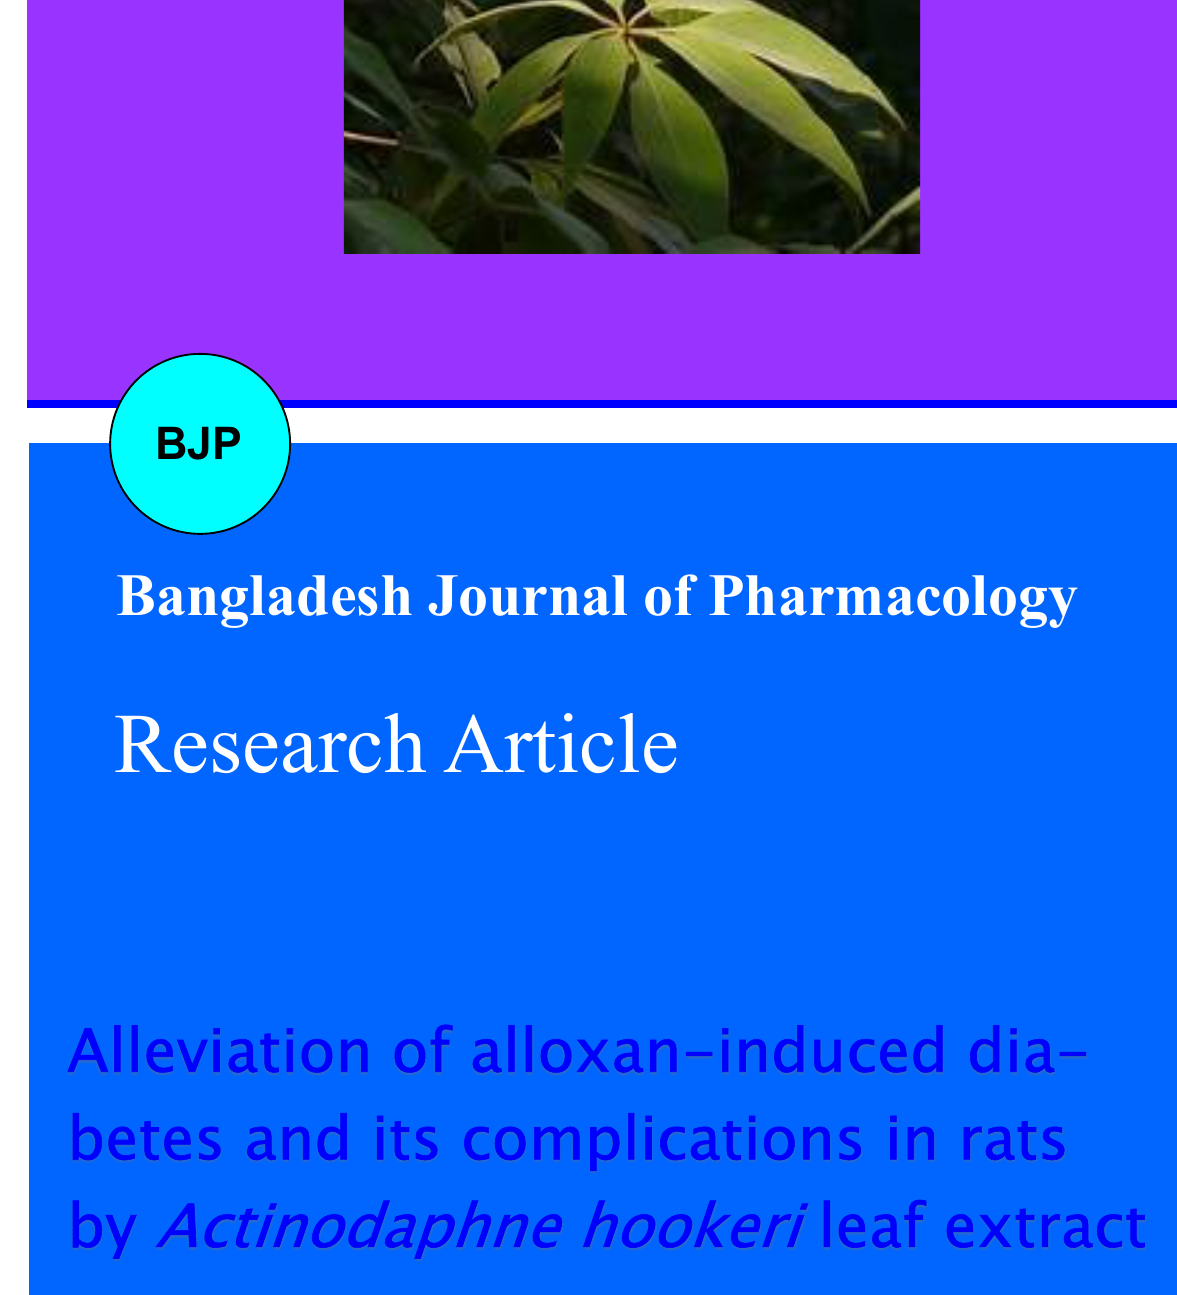
Alleviation of alloxan-induced dia- betes and its complications in rats by Actinodaphne hookeri leaf